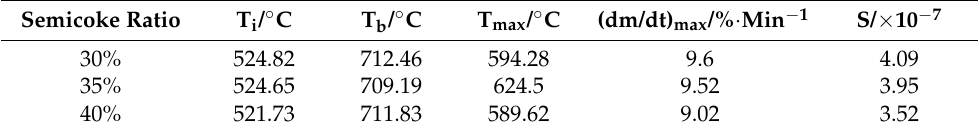
Table 4. Proportion of semicoke in a mixture of semicoke and bituminous pulverized coal. Semicoke